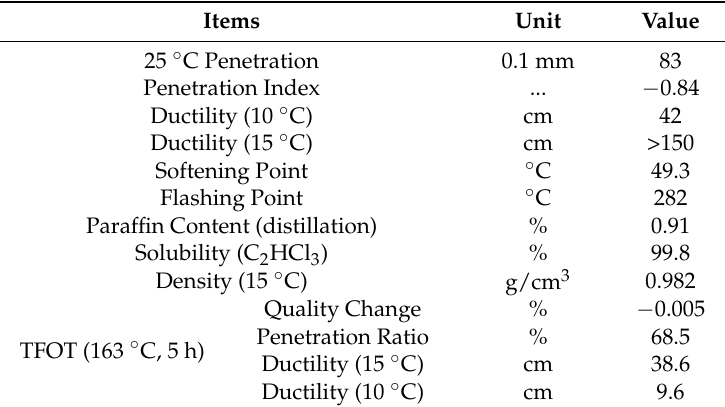
Table 1. Test results of 90# asphalt.